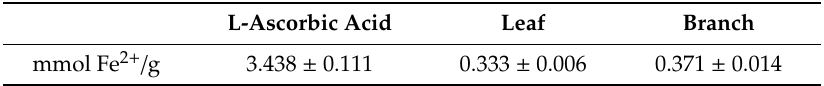
Table 4. Ferric reducing antioxidant power (FRAP) values of ascorbic acid and hot-water extracts from S. samarangense .